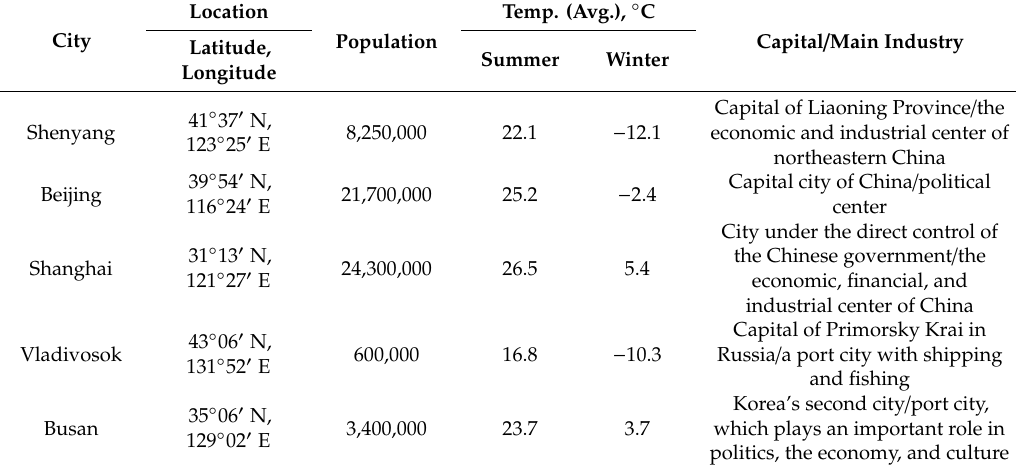
Figure 1. Airborne particulate sampling cities in East Asia. Table 1. Characteristics of sampled cities.